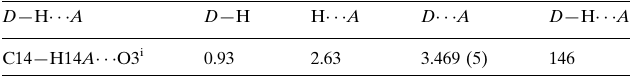
Hydrogen-bond geometry (A˚ , (cid:1)